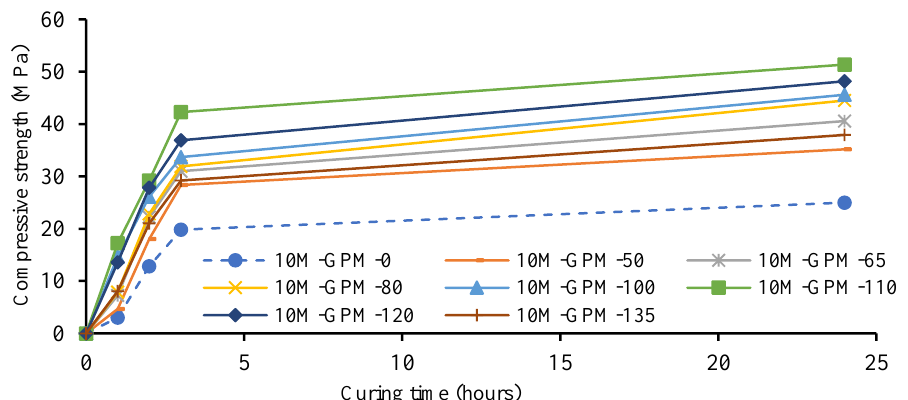
Figure 8. Compressive strength test results of the geopolymer material (GPM) using room-temperature sand and preheated sand after 1 h, 2 h, 3 h, and 1 d of hot air curing at a constant temperature of 50 °C.